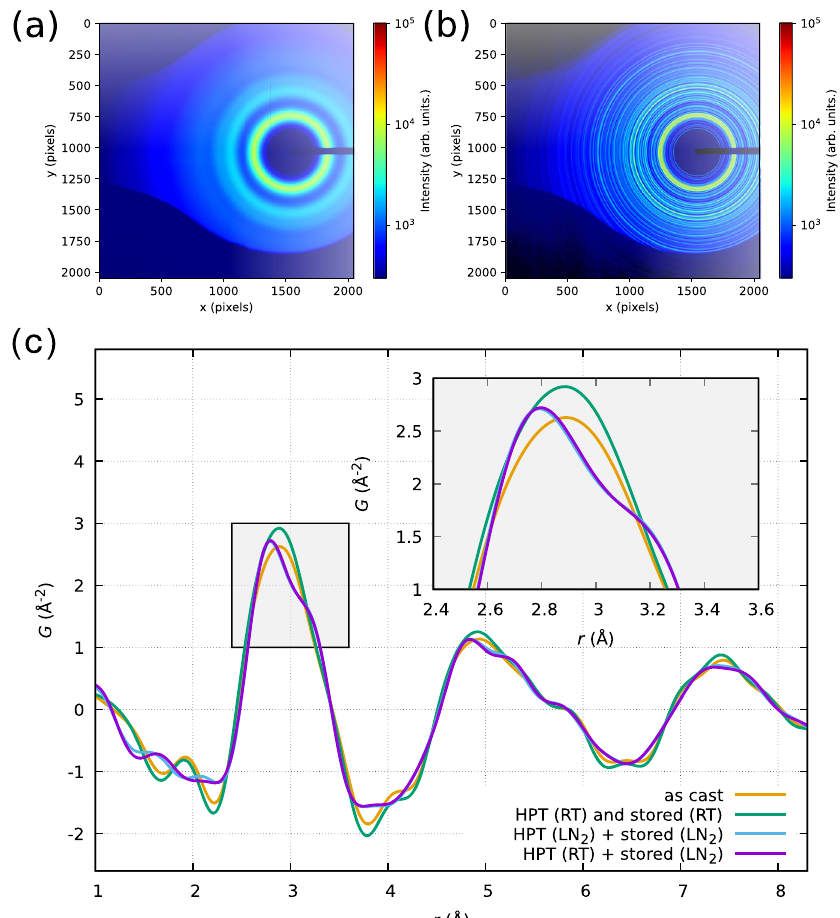
Fig. 1 2-D diffraction and pair distribution function. a Diffraction pattern of an as-cast amorphous sample, ( b ) diffraction pattern of the crystallized state. c Comparison of the reduced pair distribution function G(r) at room temperature for the as-cast, and three different HPT-deformed states. If no cryogenic storage is ensured after HPT, the sample relaxes within 1 week and the shoulders in the fi rst and second peaks of G(r) smear out indicating a certain degree of